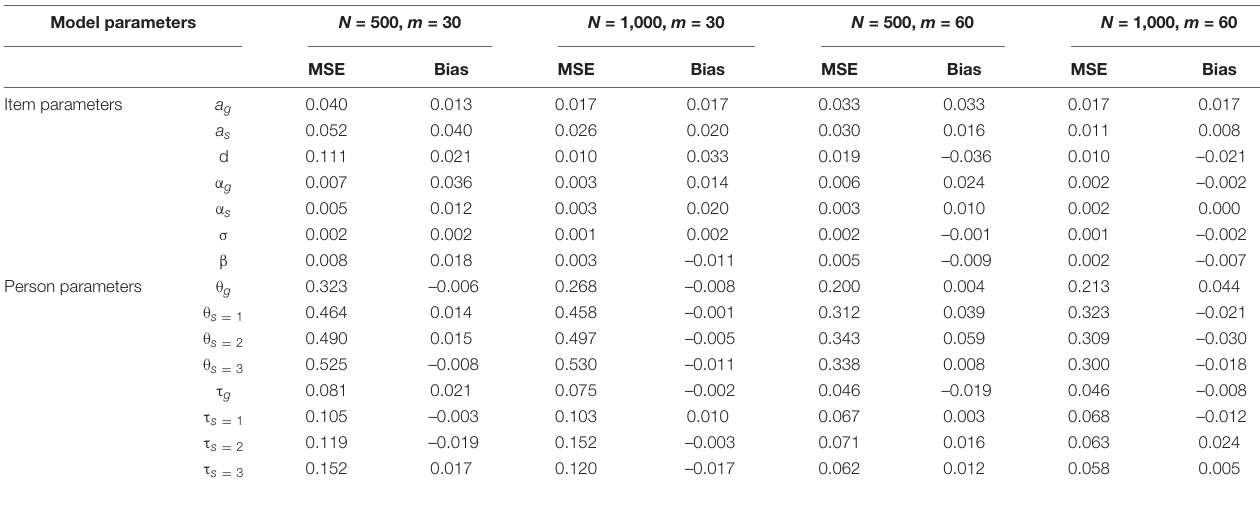
TABLE 1 | MSE and Bias for the item and person parameters. Model